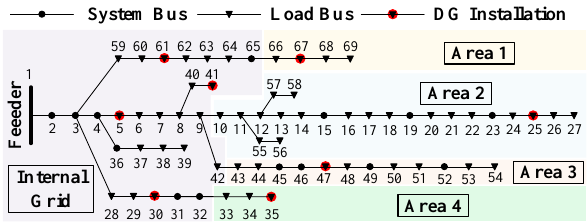
Figure 4. Modified IEEE 69-node system.